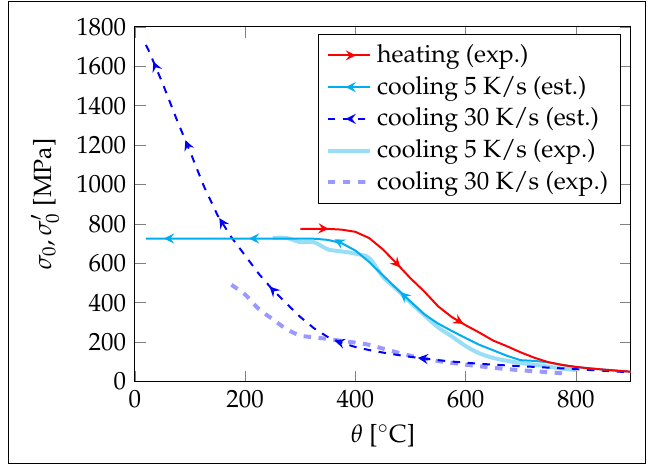
Figure 6. Estimated σ (cid:48) based on σ 0 and parameters from Table 0